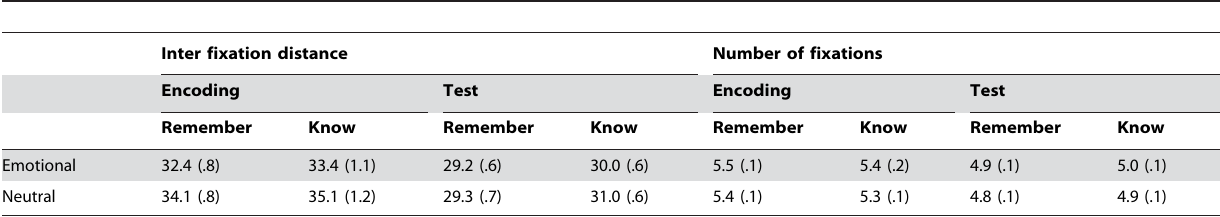
Table 2. Average inter-fixation distance (measured in eye tracking units, which are equal to 1/20 inch), and average number of fixations for remember and know responses for emotional and neutral items.